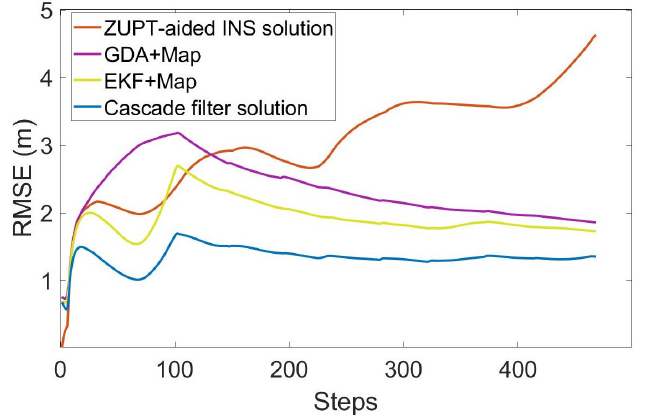
Figure 8. RMS error of each